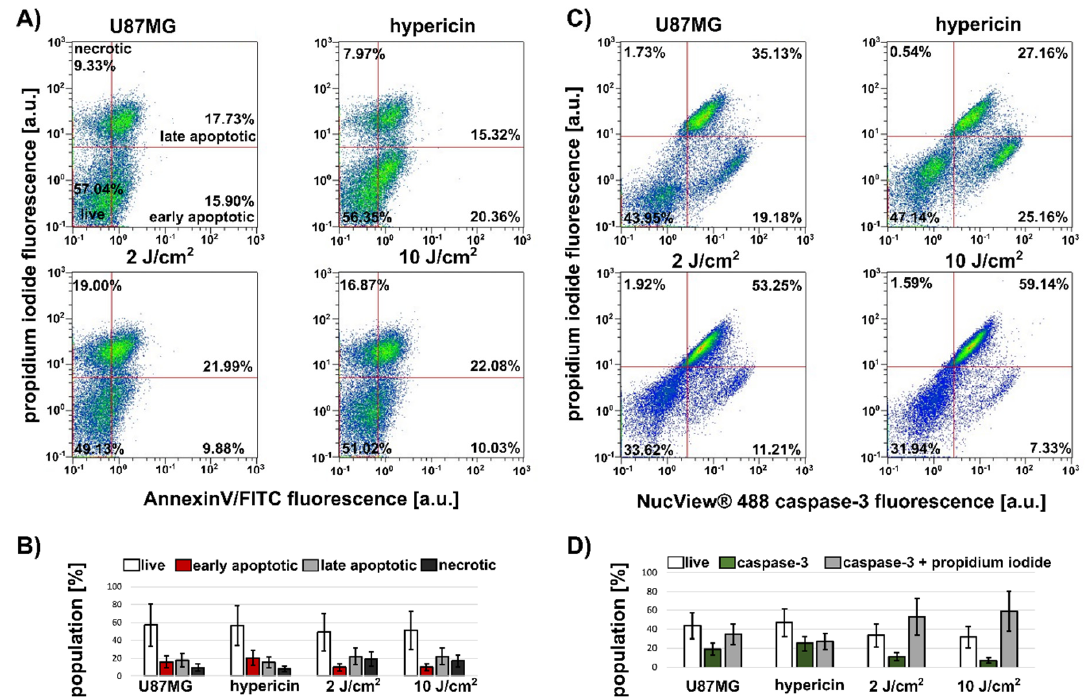
Figure 5. Flow cytometric analysis of propidium iodide and ( A ) AnnexinV/FITC and ( C ) NucView ® 488 caspase-3 fluorescence in cells derived from spheroids of U87MG cells detected under different treatment conditions: 500 nM hypericin in the dark and PDT with light doses of 2 and 10 J/cm 2 . Cell numbers in the graphs are color-coded from blue (minimum) to red (maximum). ( B , D ) Population in % corresponding to live cells (white columns), early apoptosis (red columns), late apoptosis (grey columns), necrosis (dark grey columns), caspase-3-positive (green columns), and caspase-3 + propidium iodide-positive (grey columns) cells. Experiments were performed in duplicate. The error bars represent the standard deviation of the measurements.